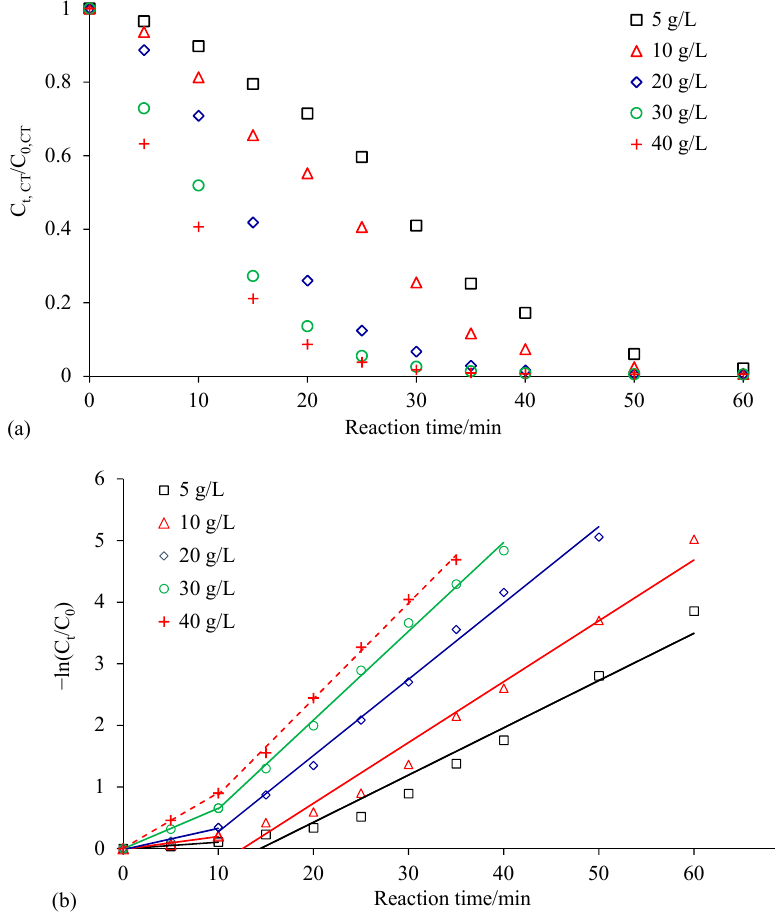
Figure 6. Effect of Ag/Fe dosage on CCl 4 degradation: ( a ) changes in CCl 4 concentration with time; ( b ) kinetics of CCl 4 degradation. Reaction conditions: 0.4 wt.% Ag/Fe dosage of 20 g/L, CCl 4 initial concentration of 20 mg/L, initial solution pH of 7, stirring rate of 200 rpm. C 0 is the initial CCl 4 concentration, and C t is the CCl 4 concentration at time t. Table 3. Rate constants for CCl 4 degradation with 0.4 wt.% Ag/Fe at different dosages.